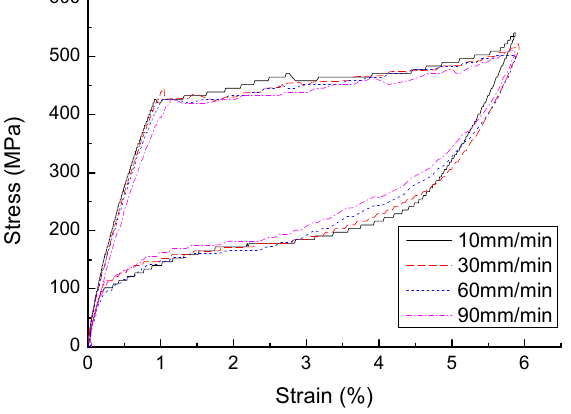
Figure 4. Stress-strain curve of austenite SMA wire with different loading rates.